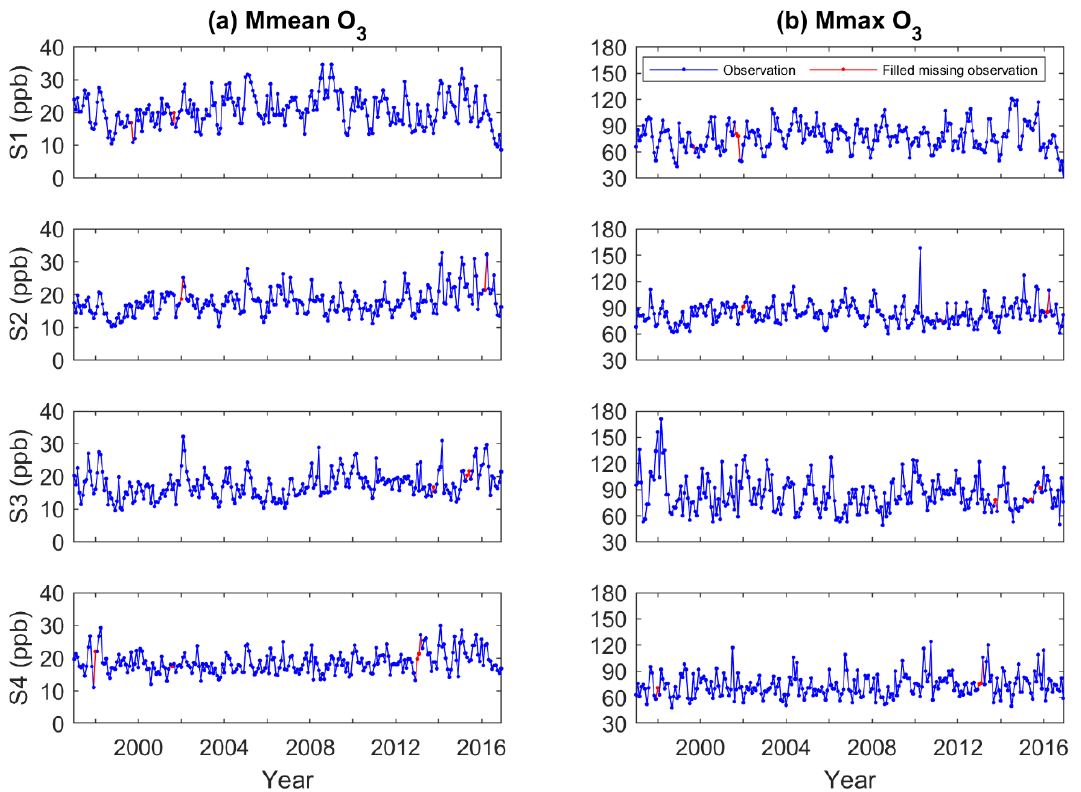
Figure 4. Time series (1997–2016) for ( a ) Monthly mean O 3 (Mmean) and ( b ) Monthly mean of daily max O 3 (Mmax).